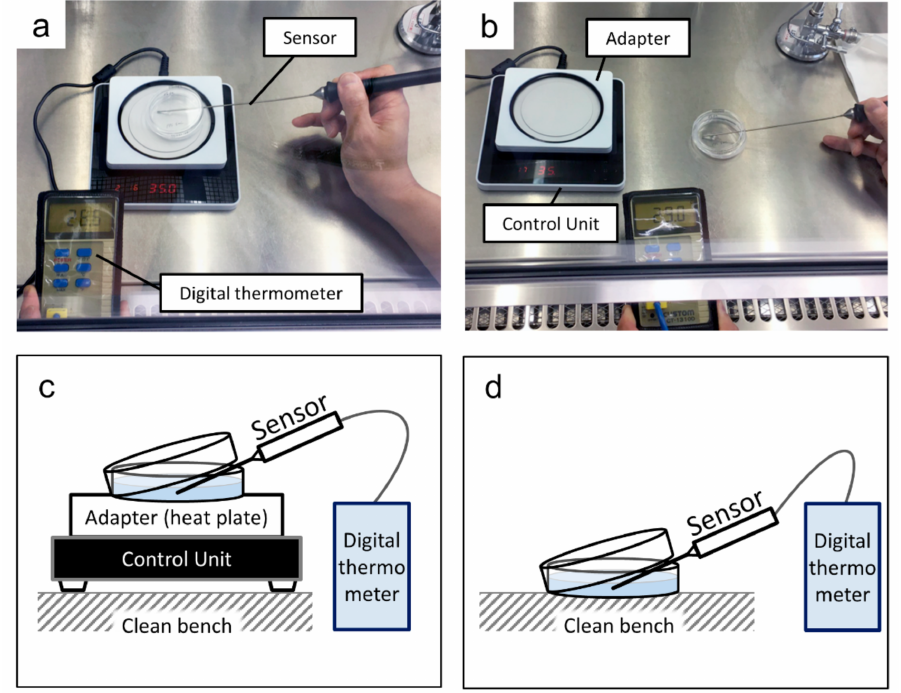
Figure 2. Measurement of the medium temperature: ( a ) the culture dish on a heat plate; ( b ) the culture dish on a working table inside a clean bench; ( c ) a schematic of the arrangement in ( a ); ( d ) a schematic of the arrangement in ( b